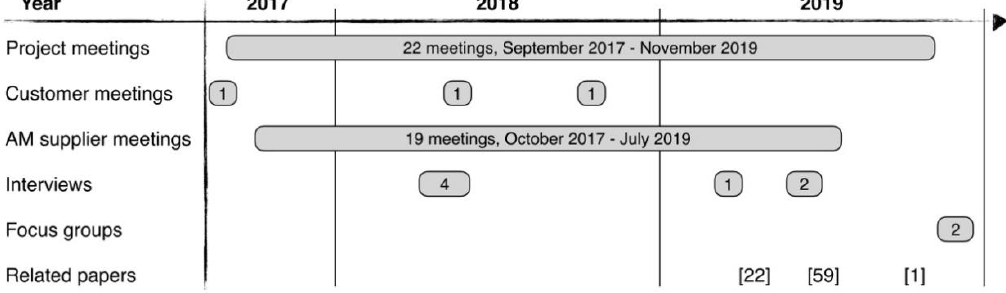
Figure 2. Time frame for the collection of data specified in Table 1. Completion of the related papers [1], [22] and [59] are indicated for reference (note that for Reference [59] submission is indicated).